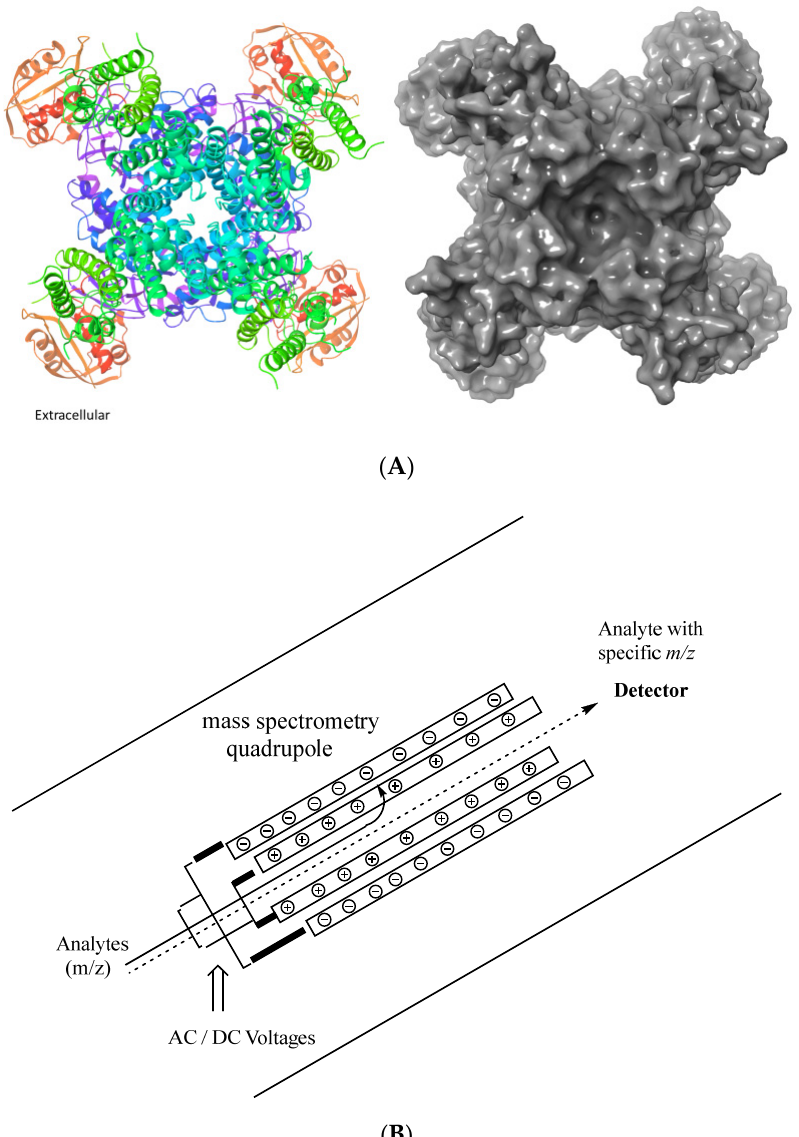
Figure 1. ( A ) Representative depiction of an extracellular view of a voltage-gated potassium channel. Ribbon representation of the hERG channel. The image was generated using Schrödinger Maesto and importing the PDB: 5VA1 3.70 Å structure [2], including the biological unit. The ribbons are colored by residue position using the default palette in Schrödinger Maestro. ( B ) Representative sketch of a mass spectrometry quadrupole.